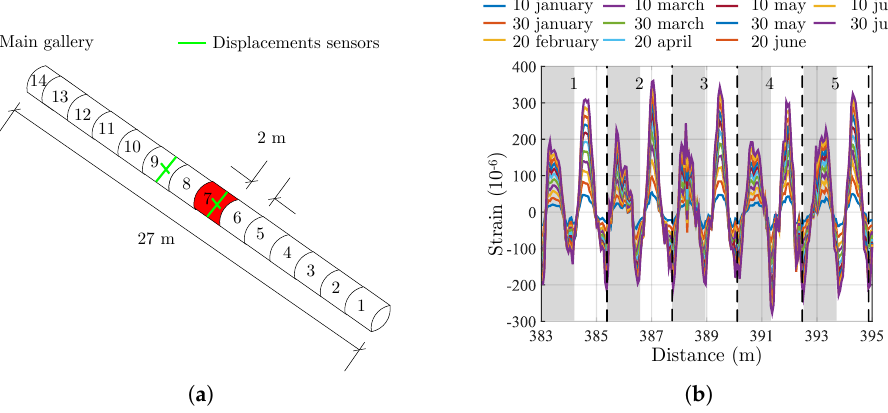
Figure 11. Scheme of the studied gallery and strain measurements. ( a ) Scheme of the studied gallery in the underground laboratory. The instrumented cell is in red and the displacement sensors are in green. ( b ) Strain measured along the